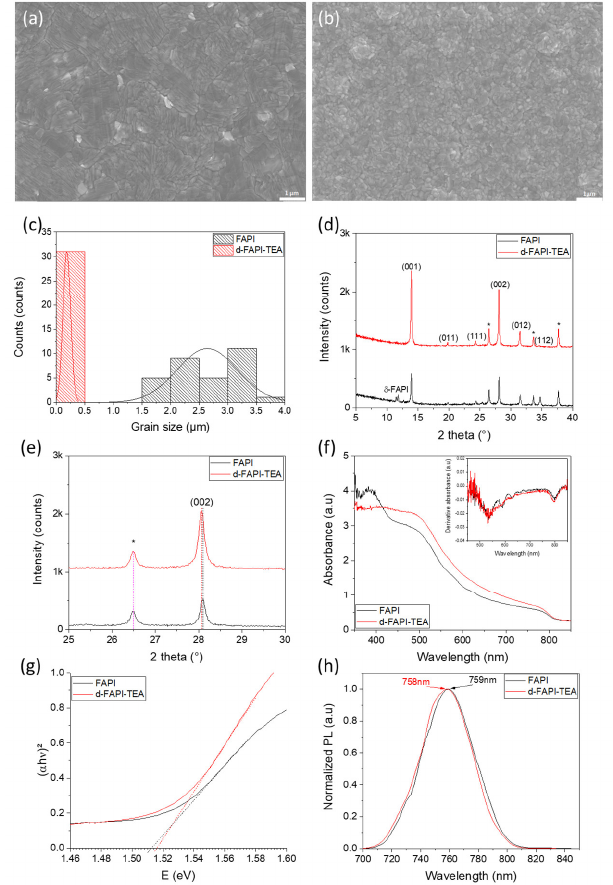
Figure 5. SEM images of ( a ) FAPI and ( b ) d-FAPI-TEA (x = 0.04) (Scale bar: 1 µm). ( c ) Grain size distribution of FAPI (large grains) and d-FAPI-TEA films. ( d ) XRD patterns of FAPI and d-FAPI-TEA films. ( e ) Same as ( d ) zoomed around (002) peak. FTO peaks are marked by the * symbol. ( f ) UV- Visible absorbance spectra of FAPI and d-FAPI-TEA perovskite films (the inset represents the derivative absorbances) ( g ) Tauc Plot of FAPI and d-FAPI-TEA absorption edge. ( h ) Steady-state photoluminescence (PL) of FAPI and d-FAPI-TEA films ( λ exc = 380